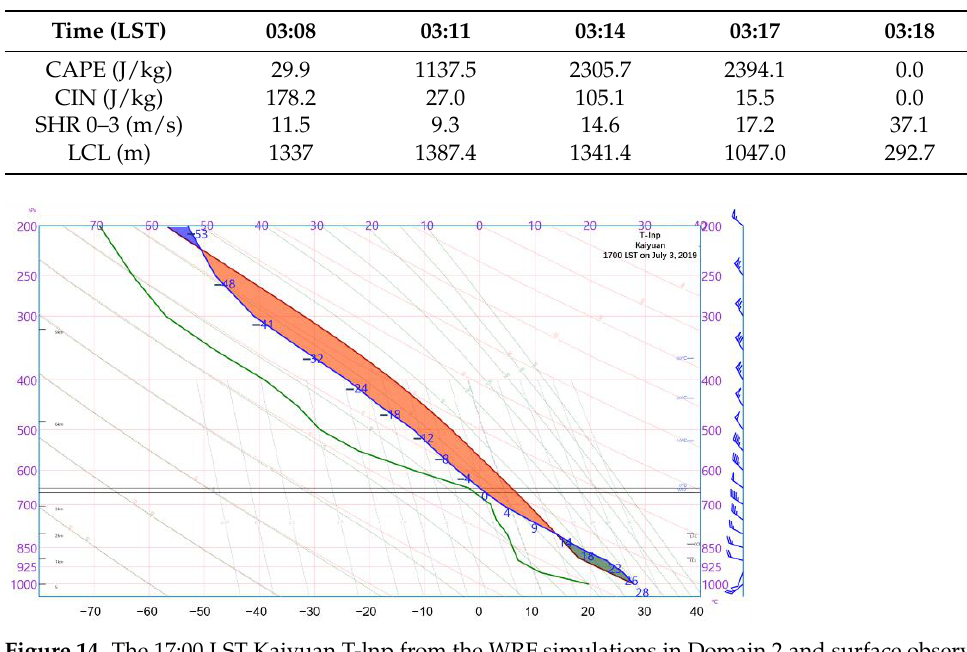
124.0° E ( b ) in Domain 2 at 17:00 LST on 3 July 2019. along 124.0 ◦ E ( b ) in Domain 2 at 17:00 LST on 3 July 2019.